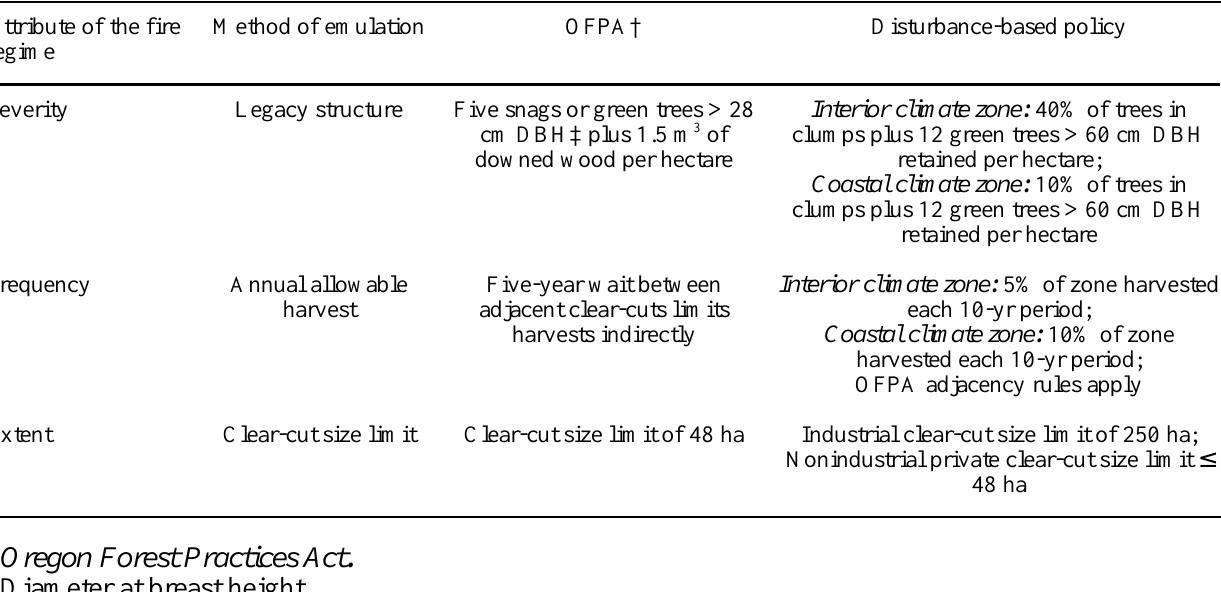
Table 1. A description of policy changes used to emulate the historical disturbance regime of the Oregon Coast Range. Source: Thompson et al.